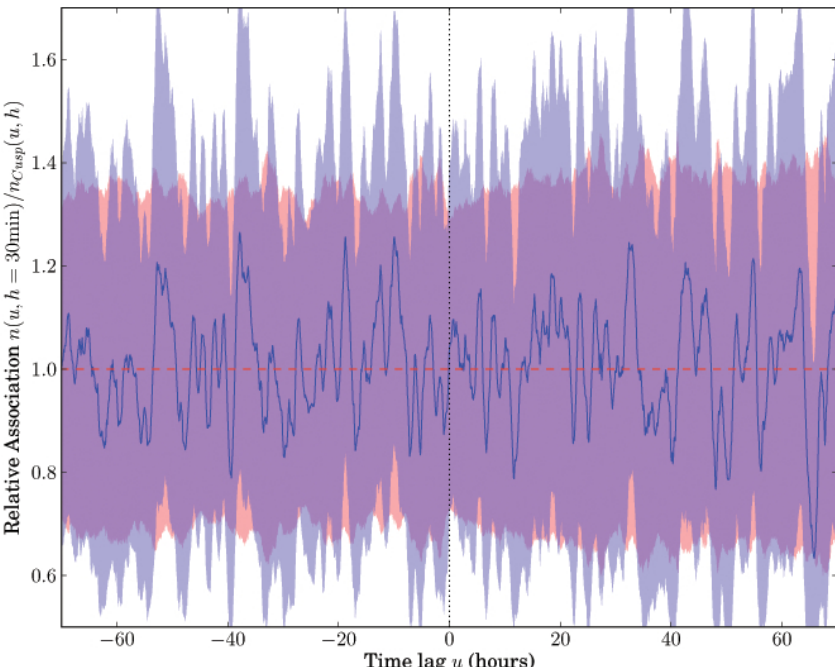
Fig. 4. Association of CEPs (blue) and cusp (red) with substorms from the Frey list only. Normalized to match asymptotic association numbers and so cusp association is 1.0. Lines represent the calculated association number; shaded areas indicate 95% confidence intervals; overlapping c.i. are